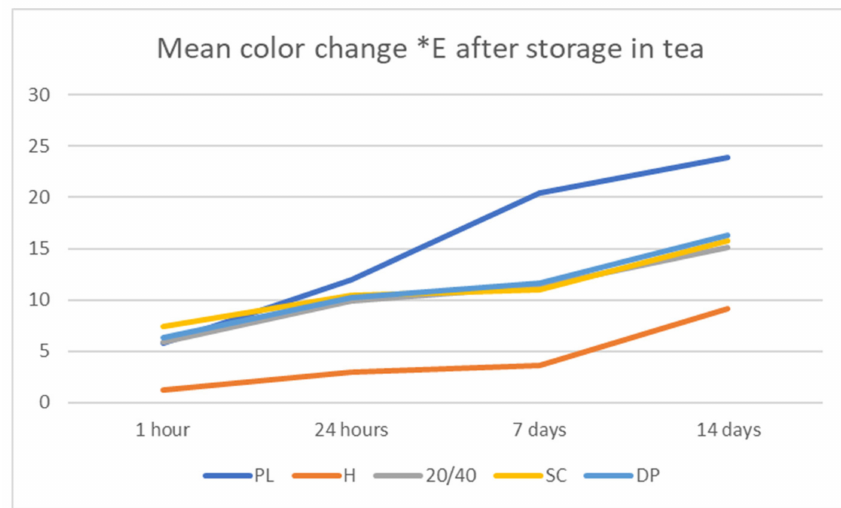
Figure 4. Mean color change ∆ E* after storage in